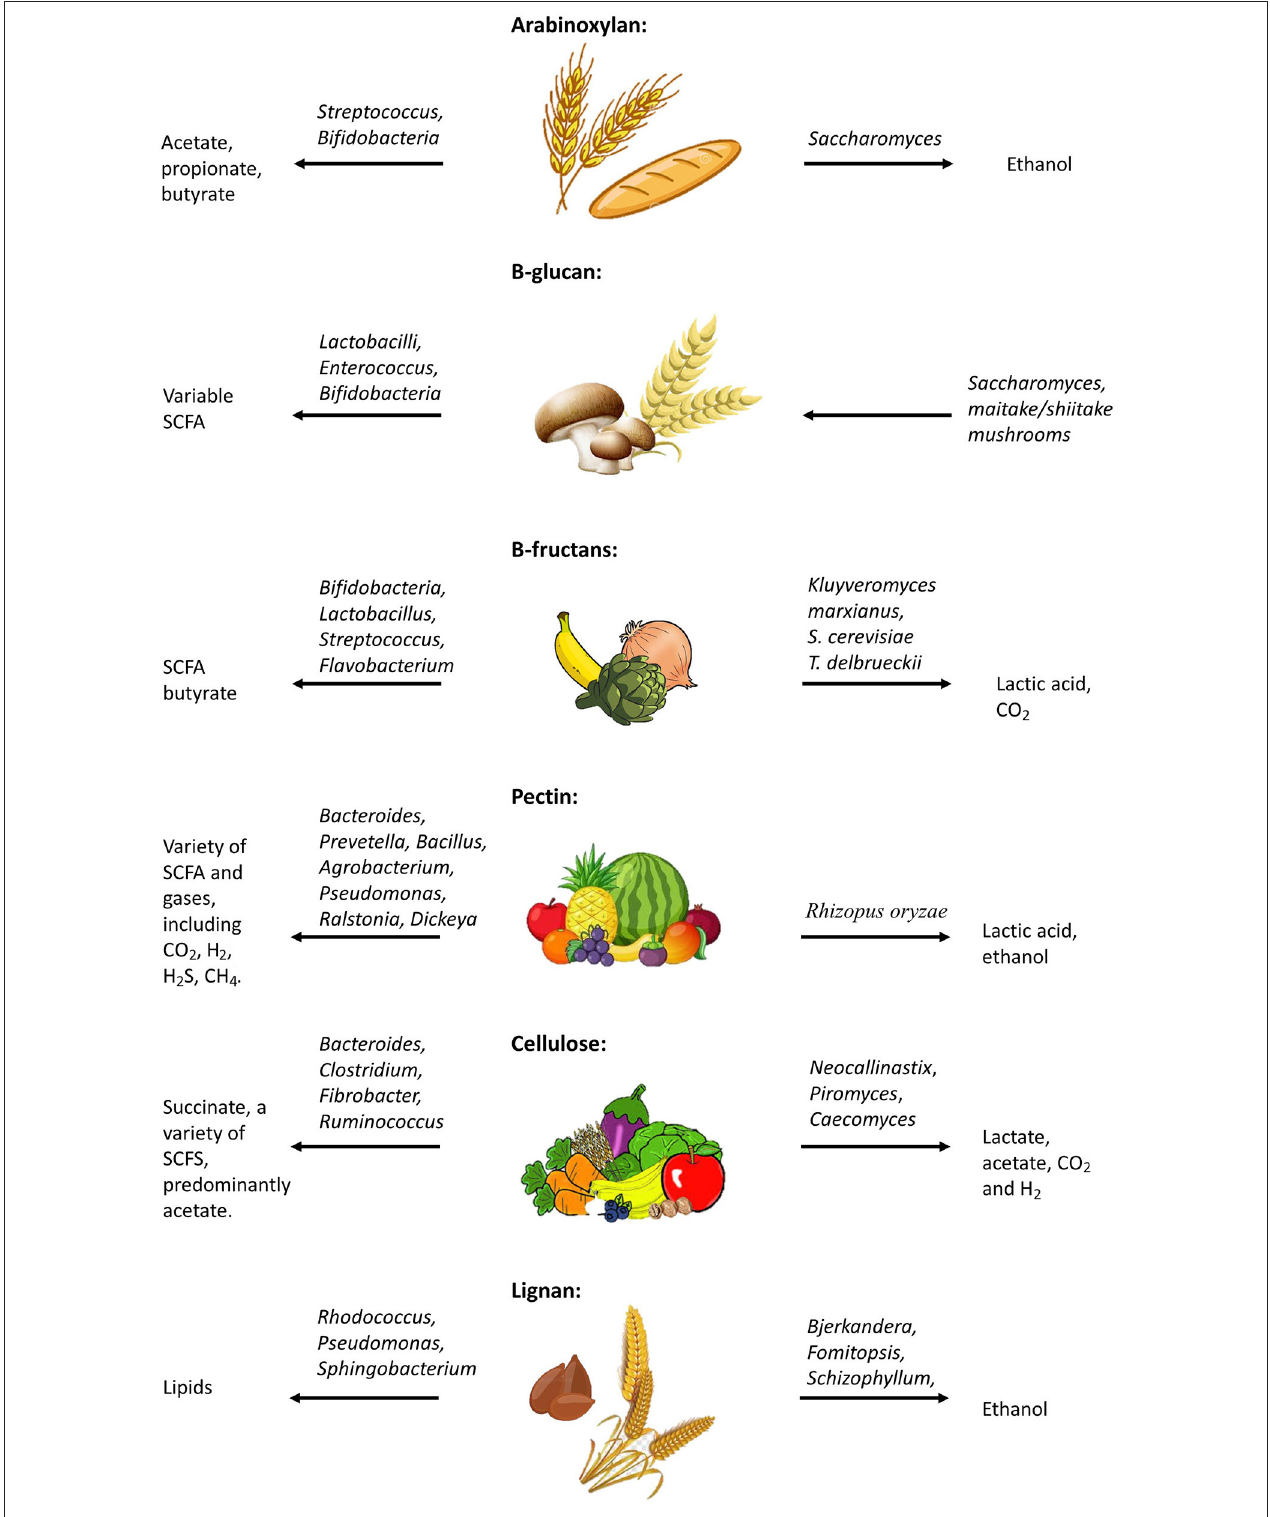
FIGURE 2 | Metabolism of dietary fibers; Effects of dysbiosis on fermentation.